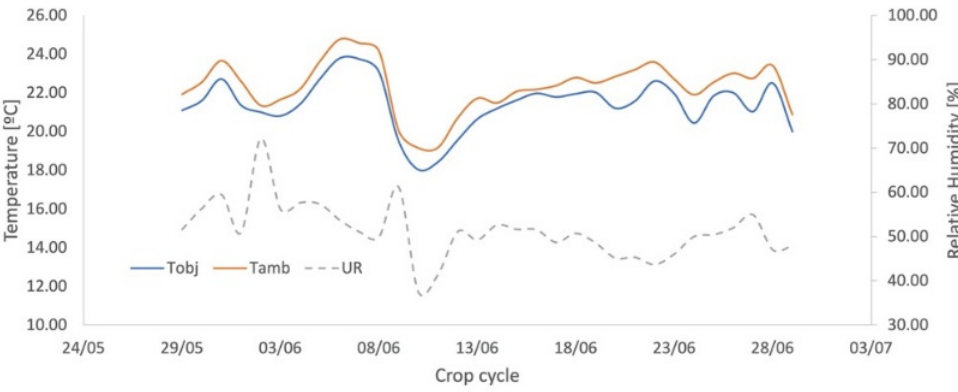
Figure 5. Ambient (T amb ) and Object Temperature (T obj ) monitoring and Relative Humidity (UR) for the auxiliary bench in NWSB parameterization.